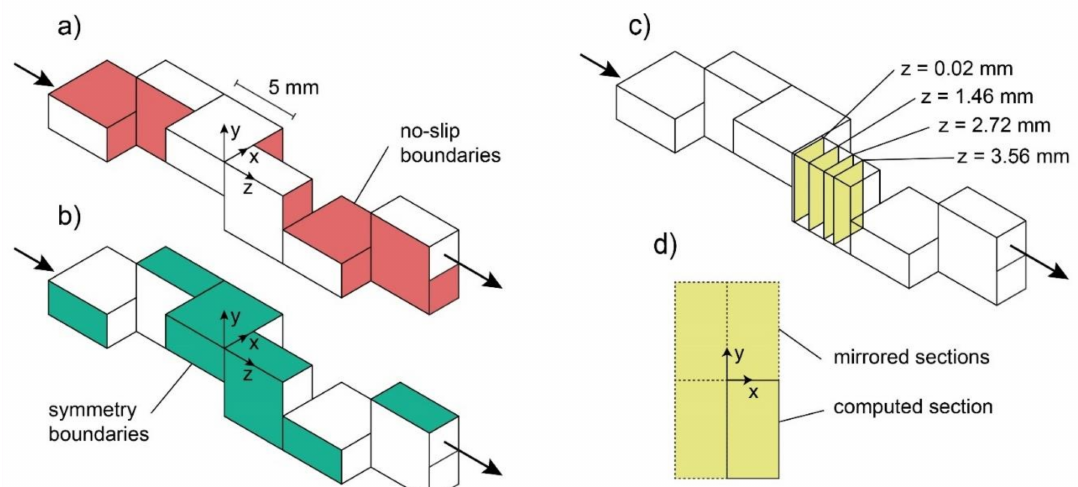
Figure 4. The geometry and boundary condition locations of the CFD model. Red faces in ( a ) denote no-slip boundaries. Green faces in ( b ) denote symmetry boundaries. The yellow planes in ( c ) show the data that are compared with the MRV data and the origin of the z -axis, which is placed relative to the interface between layers three and four. These planes are mirrored as shown in ( d ) to reconstruct the full-sized